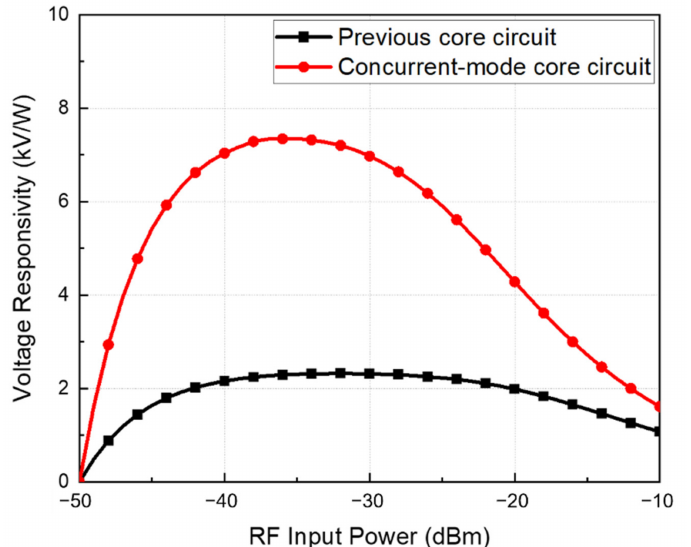
Figure 3. Simulated voltage responsivity of the detector core with gate-drain capacitors and the proposed concurrent-mode detector